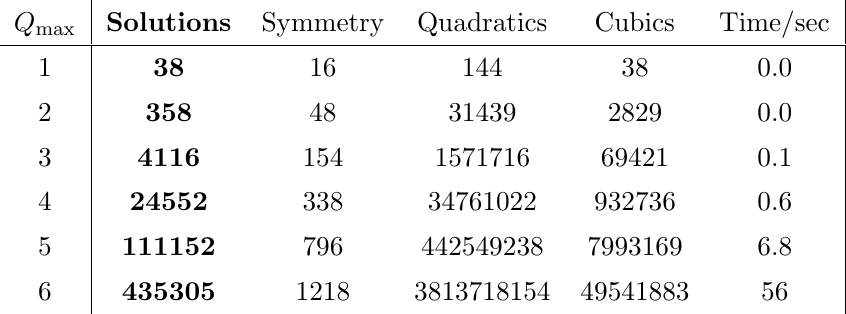
Table 3 . Number of inequivalent solutions to the anomaly equations for SM (cid:23) R fermion content and di(cid:11)erent maximum U(1) F charges Q max . Each row contains the all-zero charge solution, as well as the solutions indicated in the rows above. The column marked \Symmetry" shows how many of the solutions are CIS. We also list the number of quadratic and cubic anomaly equations checked by the program, as well as the real time taken for computation in seconds on a modern DELL TM XPS 13-9350